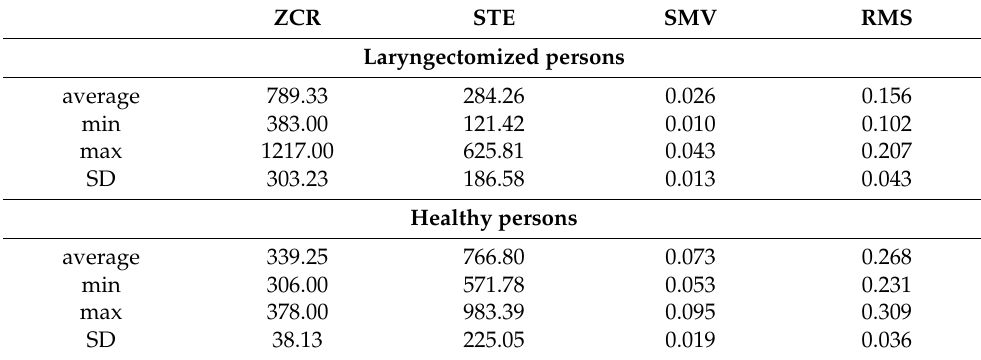
Table 4. The distribution of the values of the features: the third phonetic segments „ka”—the word